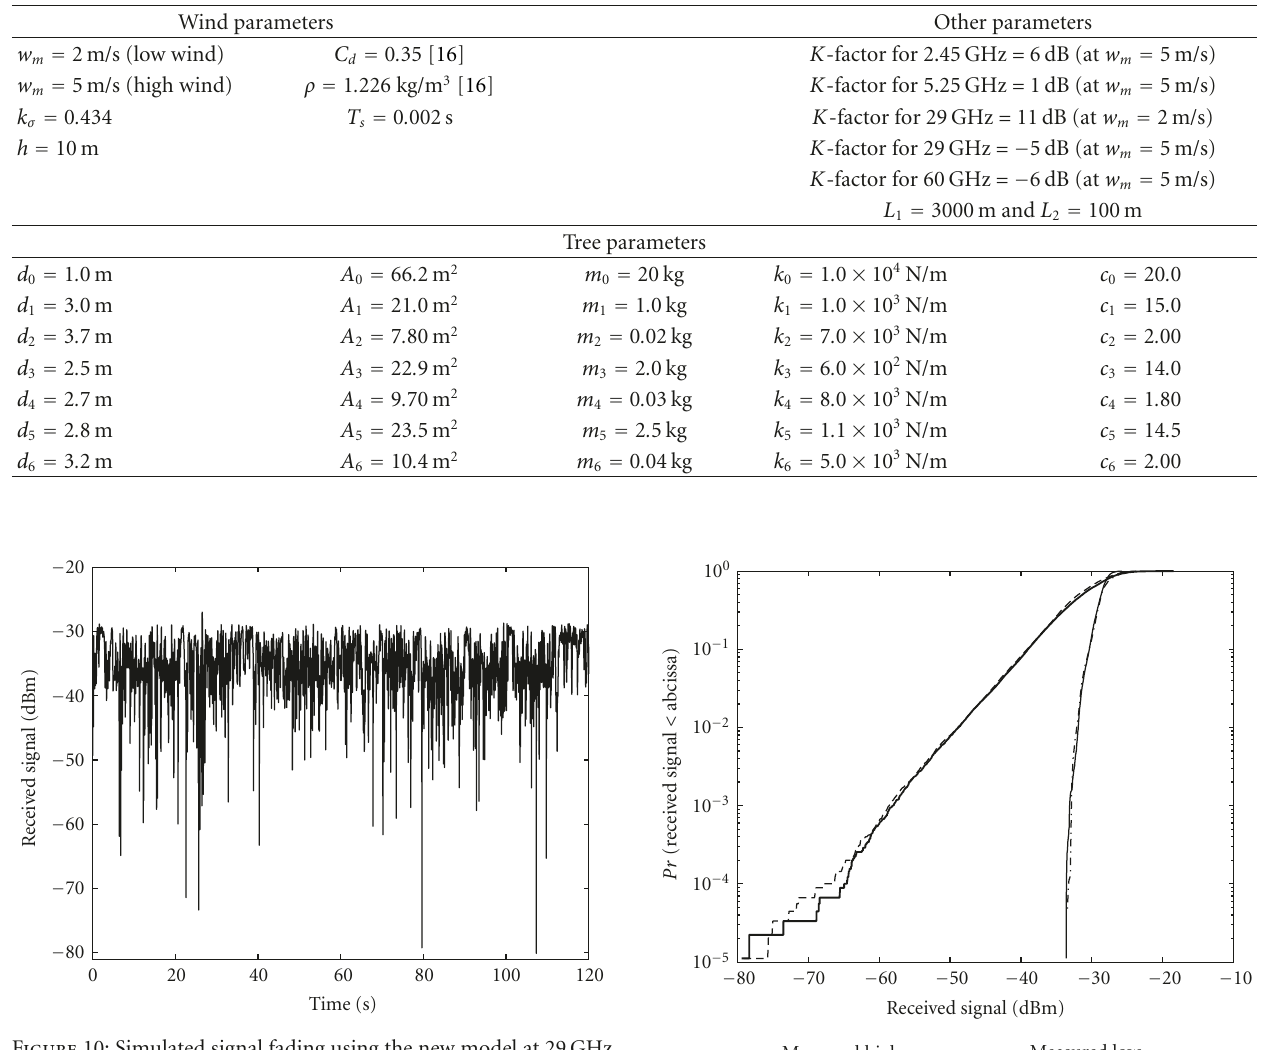
Figure 10: Simulated signal fading using the new model at 29GHz during high wind speed conditions ( w m = 5 m/s). All simulation parameters are given in Table 3.